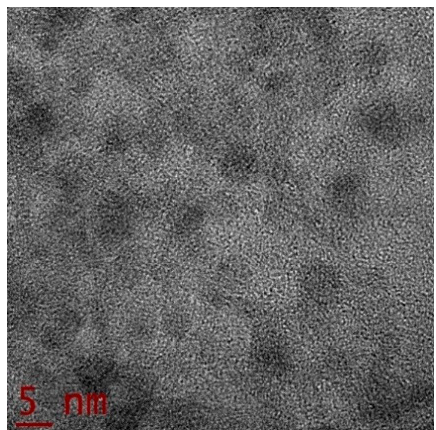
Figure 4. High-Resolution TEM image of the Au-Pt NPs embedded in TiO 2 film studied.